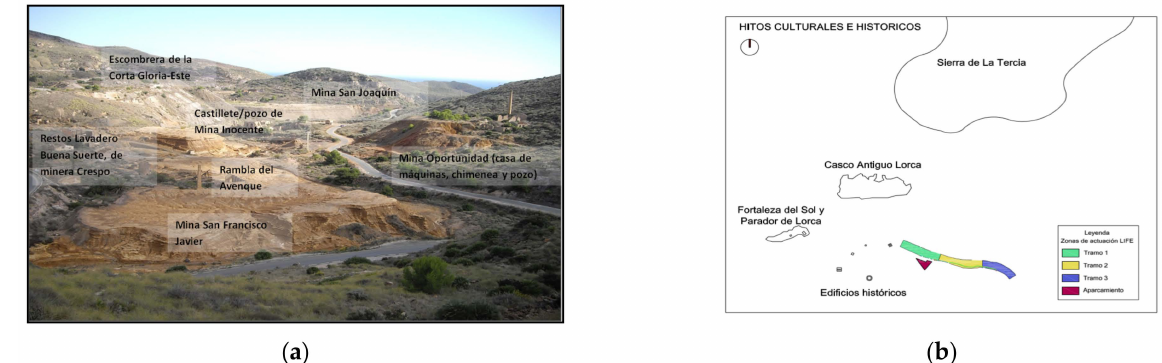
Figure A4. Definition of nearby cultural and historical landmarks for: ( a ) Case Study 1, and ( b ) Case Study 2.